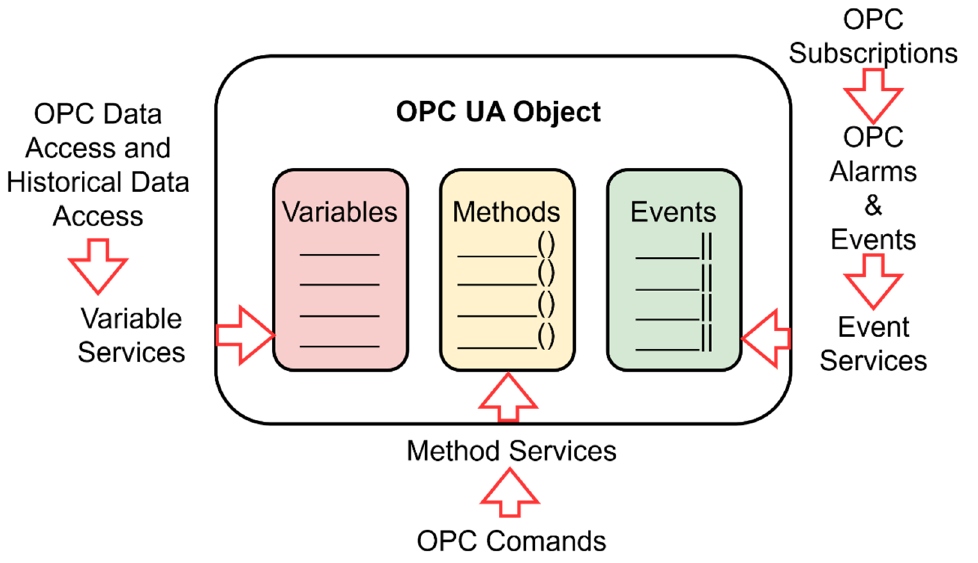
Figure 13. OPC UA